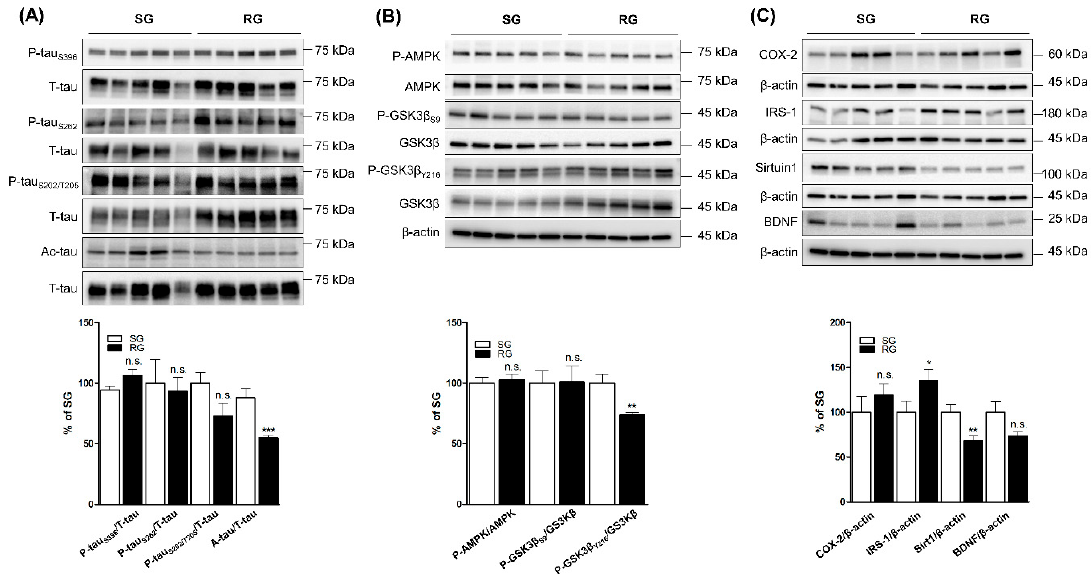
Figure 3. Effect of three-month aerobic exercise on the phosphorylation and acetylation of tau and related proteins. Comparison of levels of proteins in ipsilateral cortices in the RG (black bar) and SG (white bar) ( n = 9 per group). ( A ) Phosphorylated tau and acetylated tau. ( B ) p-AMPK, p-GSK3 β S9, and p-GSK3 β Y216 . ( C ) COX-2, IRS-1, SIRT1, and BDNF. * p < 0.05, ** p < 0.01, and *** p < 0.01 vs. SC group by Mann–Whitney U test. Vertical bars in graphs indicate standard deviations. RG—Rehabilitation group